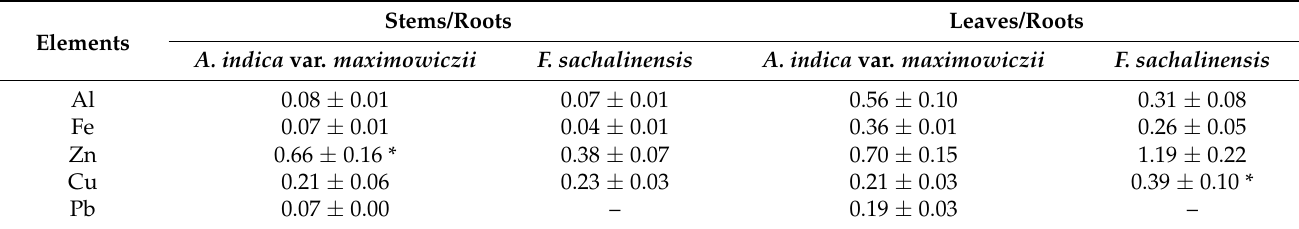
Table 3. Translocation factors (TFs) of elements in A. indica var. maximowiczii and F. sachalinensis .